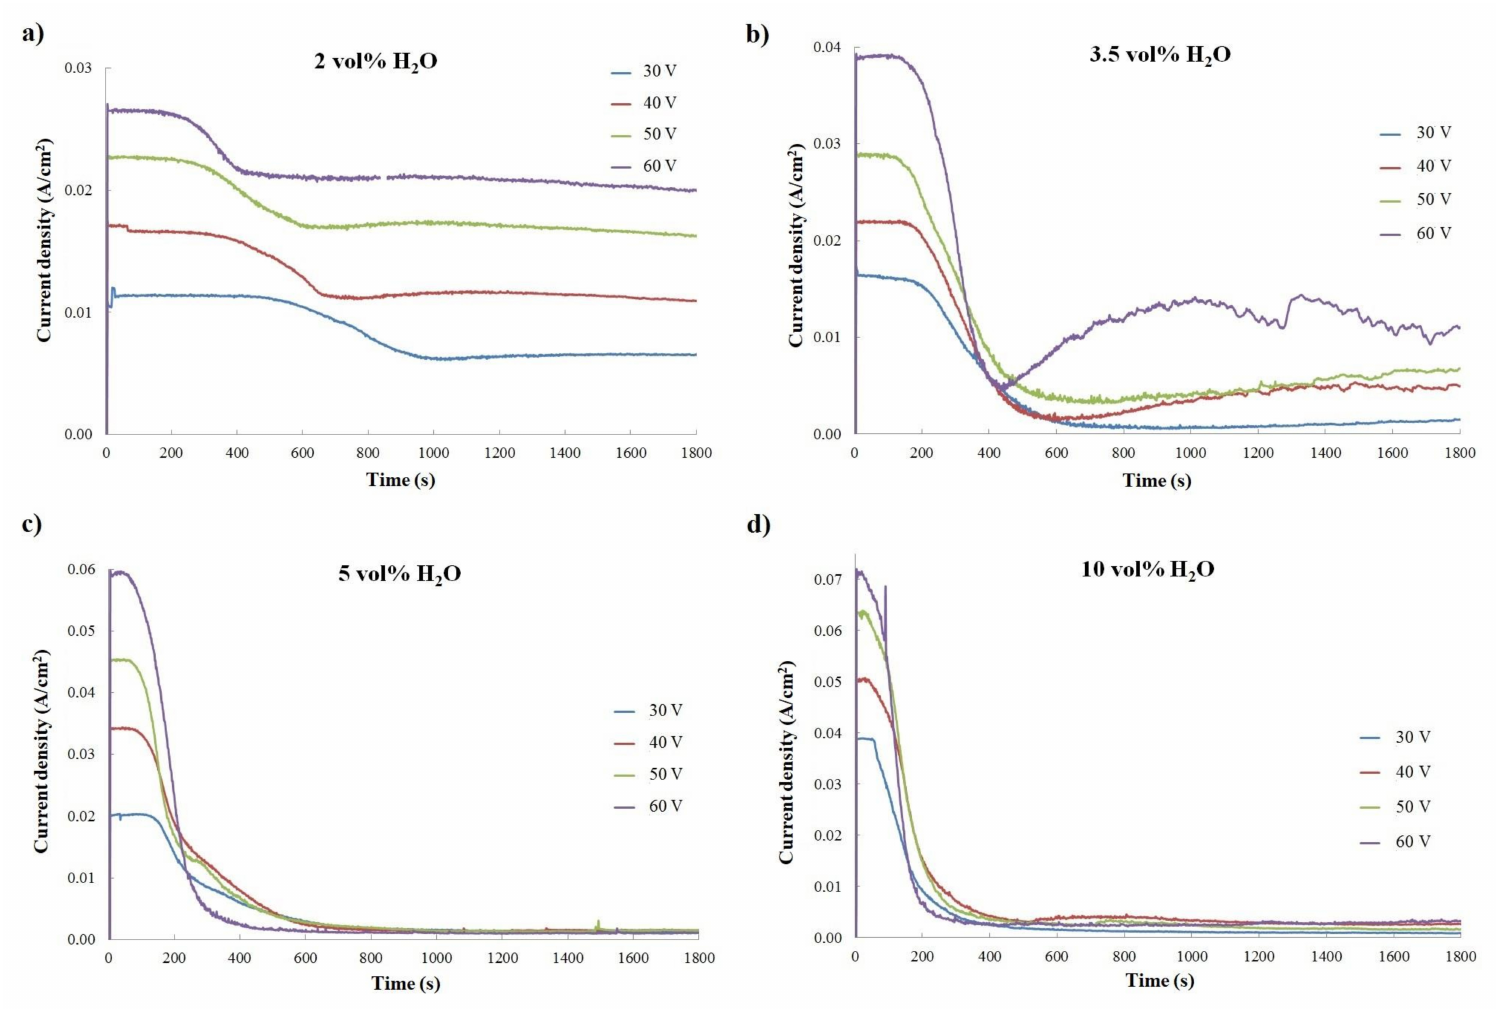
Figure 1. Current density in the function of anodization time showed, depending on anodization voltage for constant electrolyte composition: ( a ) 2 vol% of H 2 O; ( b ) 3.5 vol% of H 2 O; ( c ) 5 vol% of H 2 O; and ( d ) 10 vol% of H 2